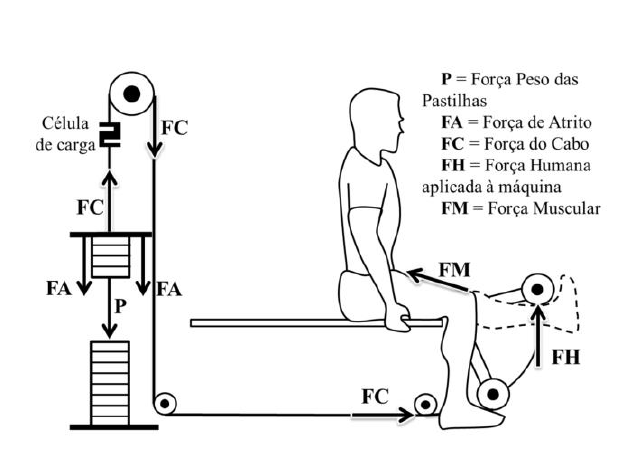
Figura 2. Esquema representativo das principais forças atuantes durante a fase ascendente da carga em um exercício de extensão de joelhos realizado na máquina de musculação Mesa Romana.